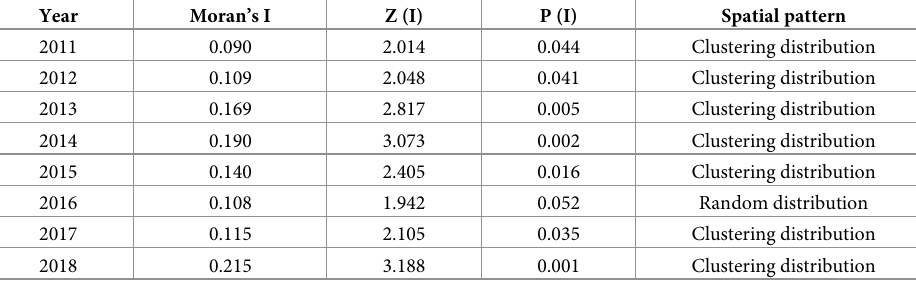
Table 1. Characteristics of spatial clustering of travel demands to North